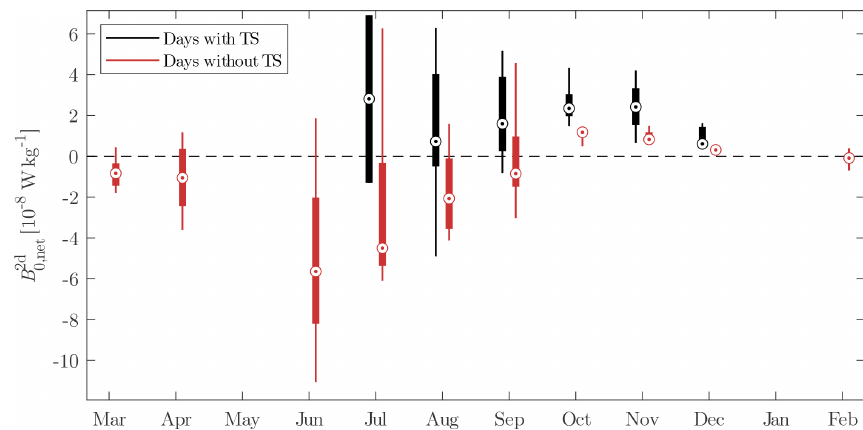
Figure B1. Box plots of the 2d averaged net surface buoyancy flux for each month, depending on the occurrence of TS events.